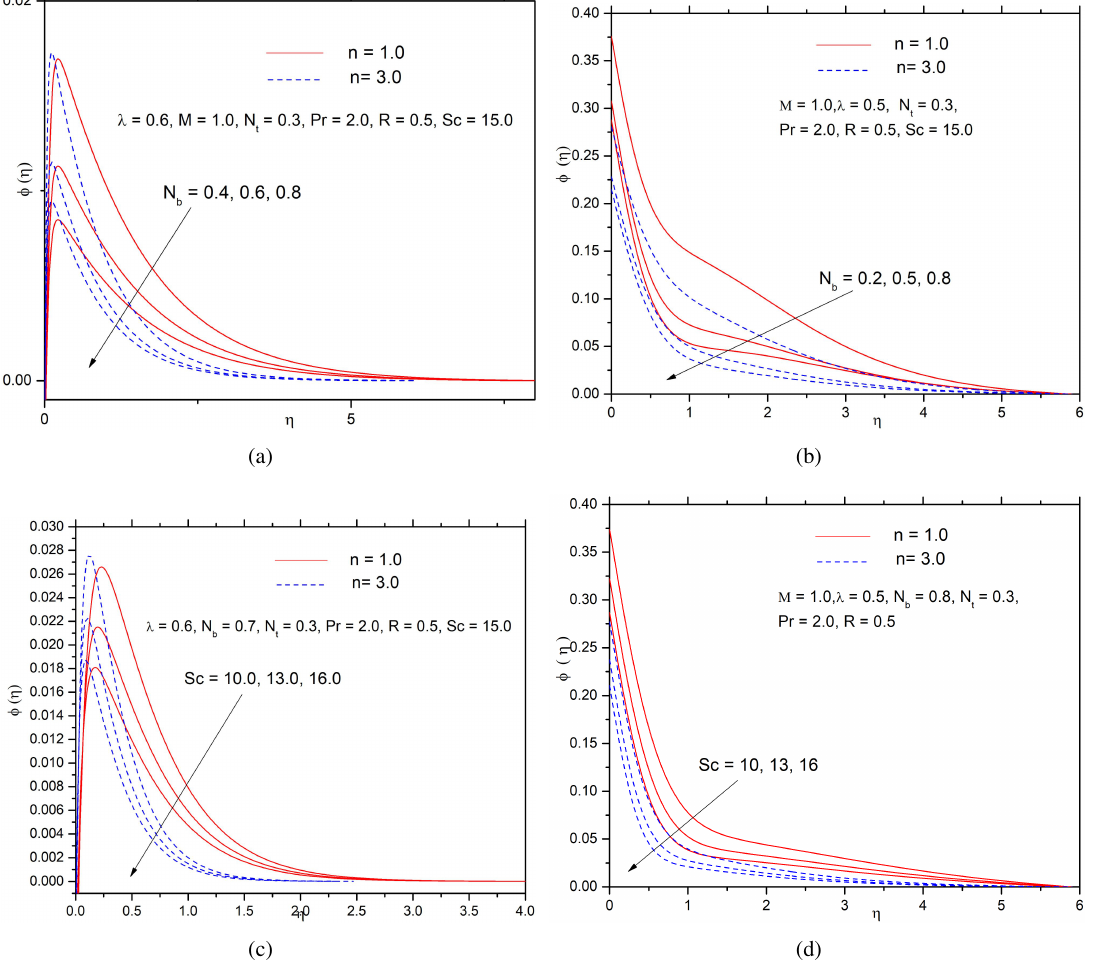
Fig. 9 Effects of N b , the parameter for Brownian motion for (a) ZMF and (b) PMF and Schmidt number Sc for (c) ZMF and (d) PMF on nanoparticle volume fraction φ ( η ) .